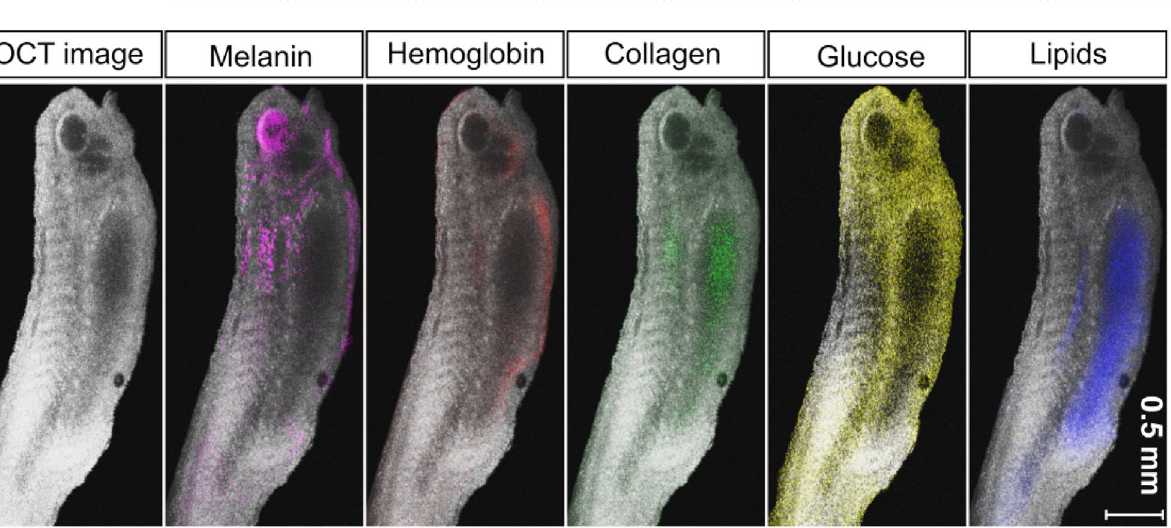
Figure 6. Qualitative illustrations of the superposition of the spatial mapping distribution of melanin (in pink), hemoglobin (magenta), collagen (green), glucose (yellow) and lipids (blue) within a tadpole obtained using the technique proposed, over a structural OCT image of the same tadpole. Similar in vivo images were obtained when imaging other four tadpoles. The image on the left shows the bare OCT image of the tadpole over which the maps of the chromophores were